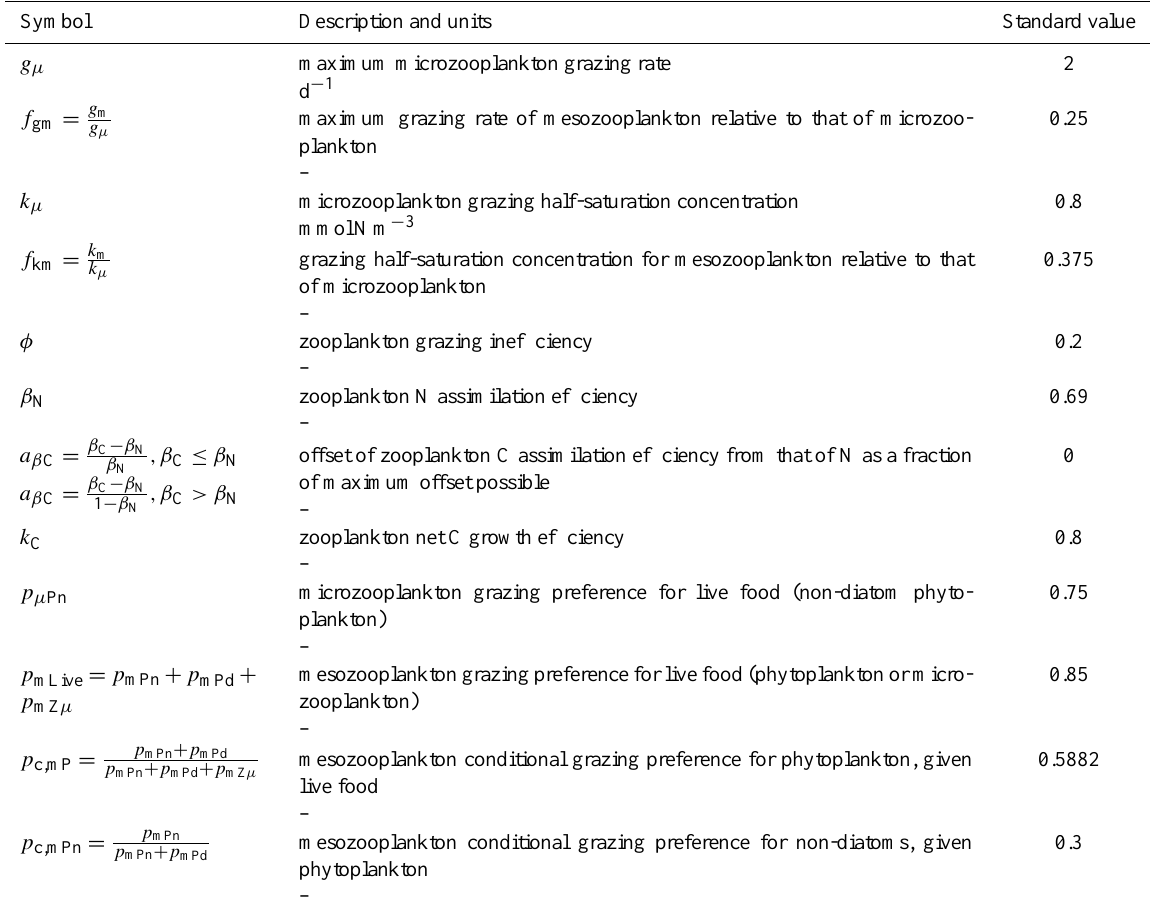
Table A2. MEDUSA zooplankton parameters (MarMOT 1.1